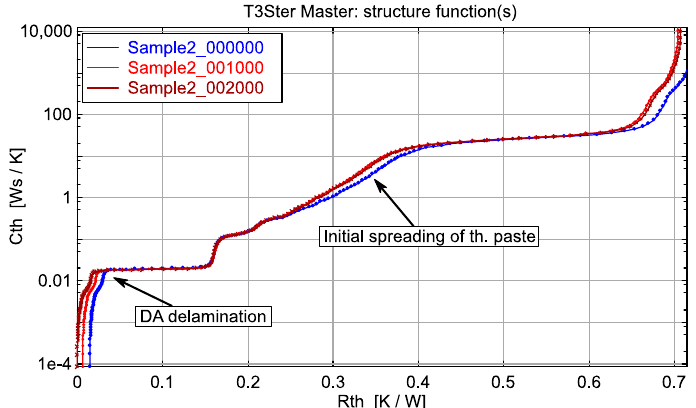
Figure 11. Structure function of Sample 2 in the initial state (blue) and after every one thousand cycles (red, brown) shifted right to fit at base-plate capacitance step.